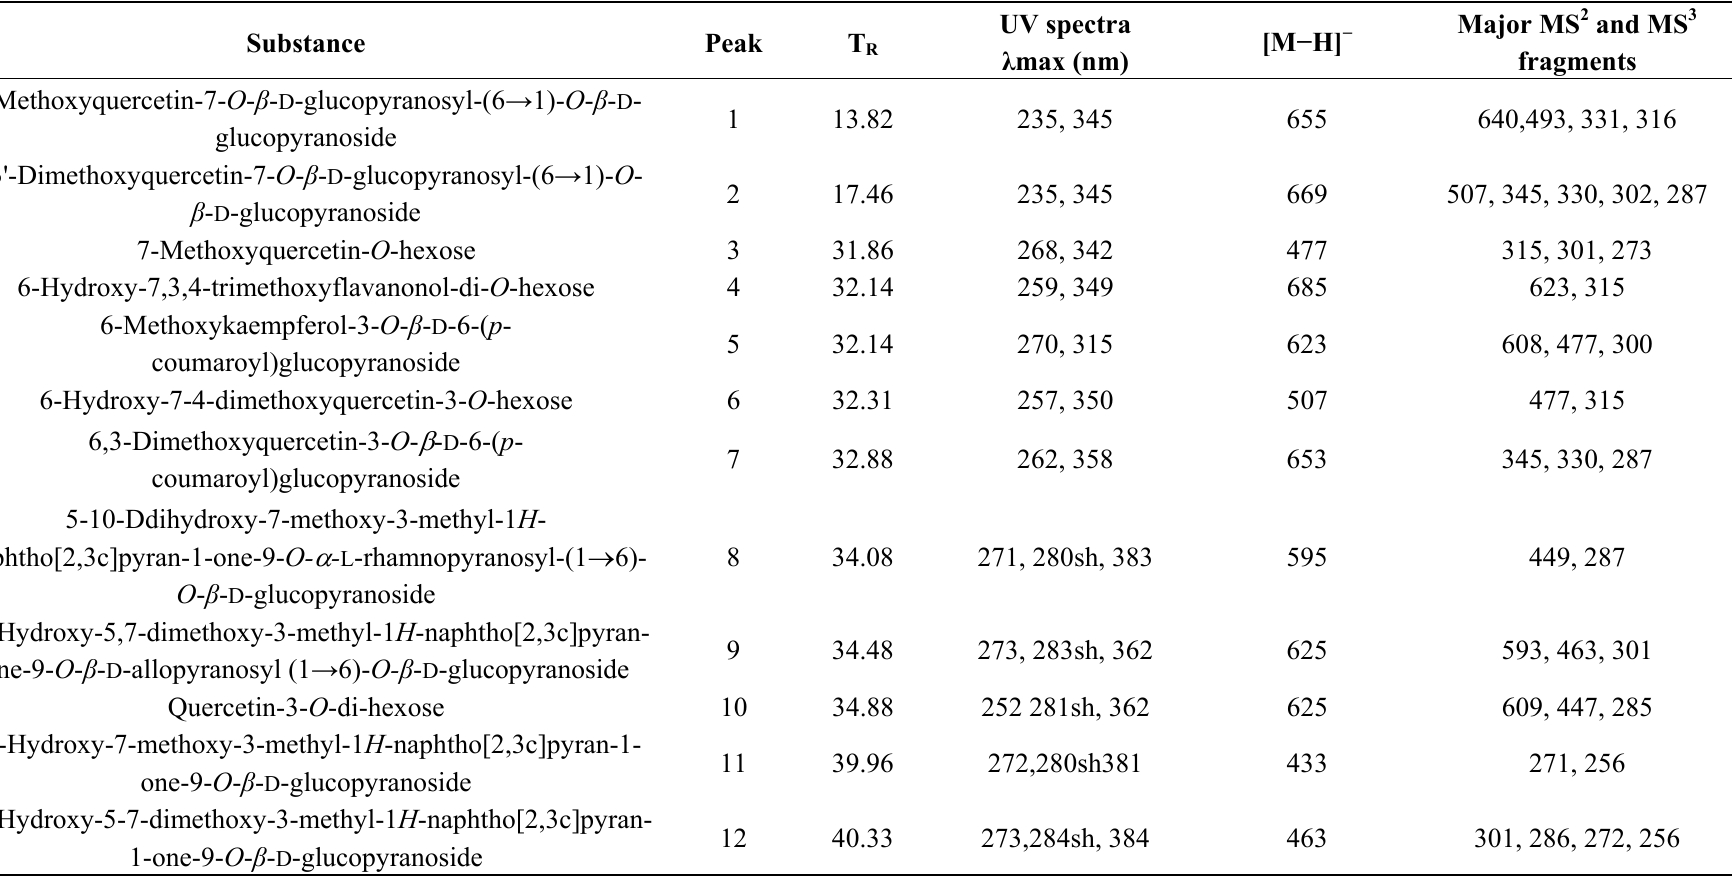
Table 1. ESI-MS and ESI-MS n product ions of compounds occurring in the methanol extracts of capitulae from P. chiquitensis